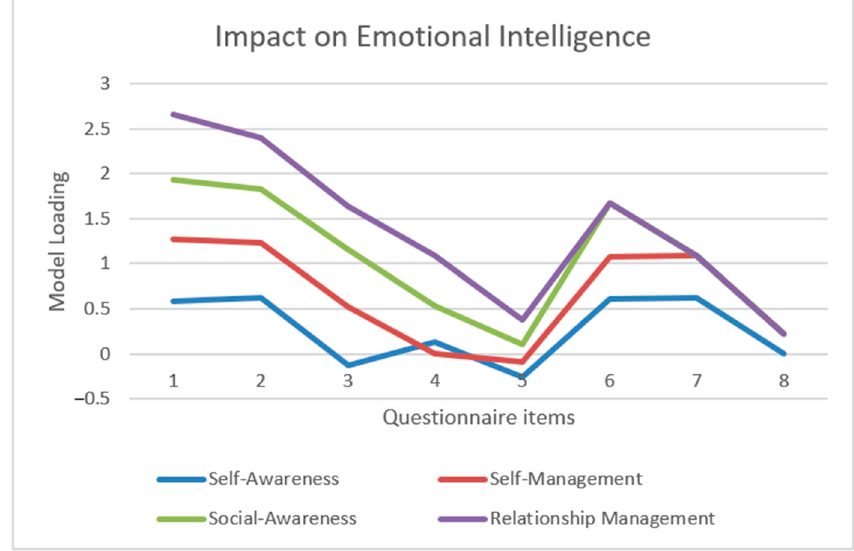
Figure 3. Areas of concern regarding the impact on Emotional Intelligence (EI). Table 5. Structural Model—Direct Effect Results of Emotional Intelligence (EI) on Organisational Performance (OP).